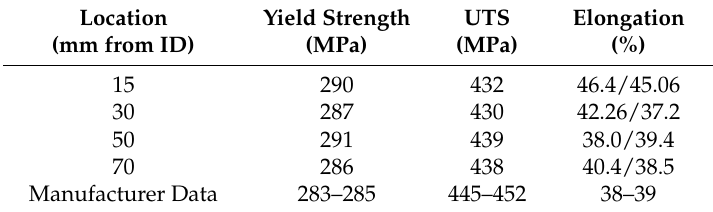
Table 1. Tensile test results at different locations throughout the thickness of the plate.